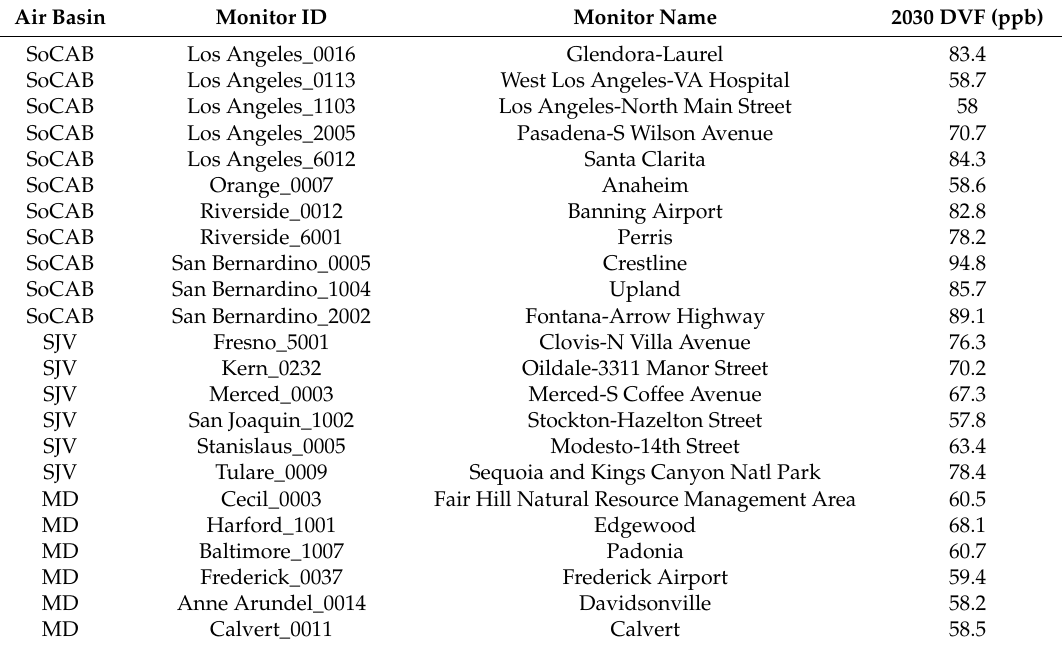
Table 1. List of monitoring sites selected for analysis and future-year design values (DVF) at these sites.